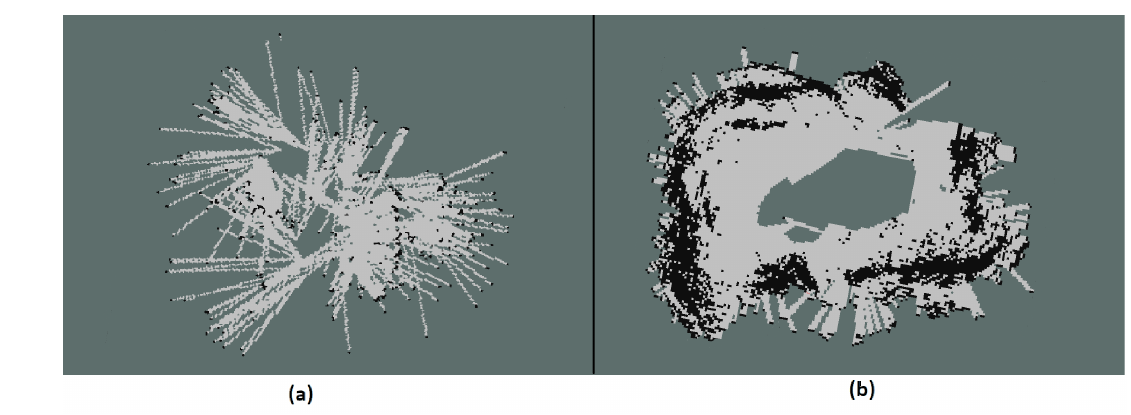
Figure 14. Two-dimensional Occupancy Grid used: ( a ) Raw projected ultrasound measurements for SLAM ( b ) Raw projected ultrasound measurements for mapping and laser scanner for SLAM localization stack.